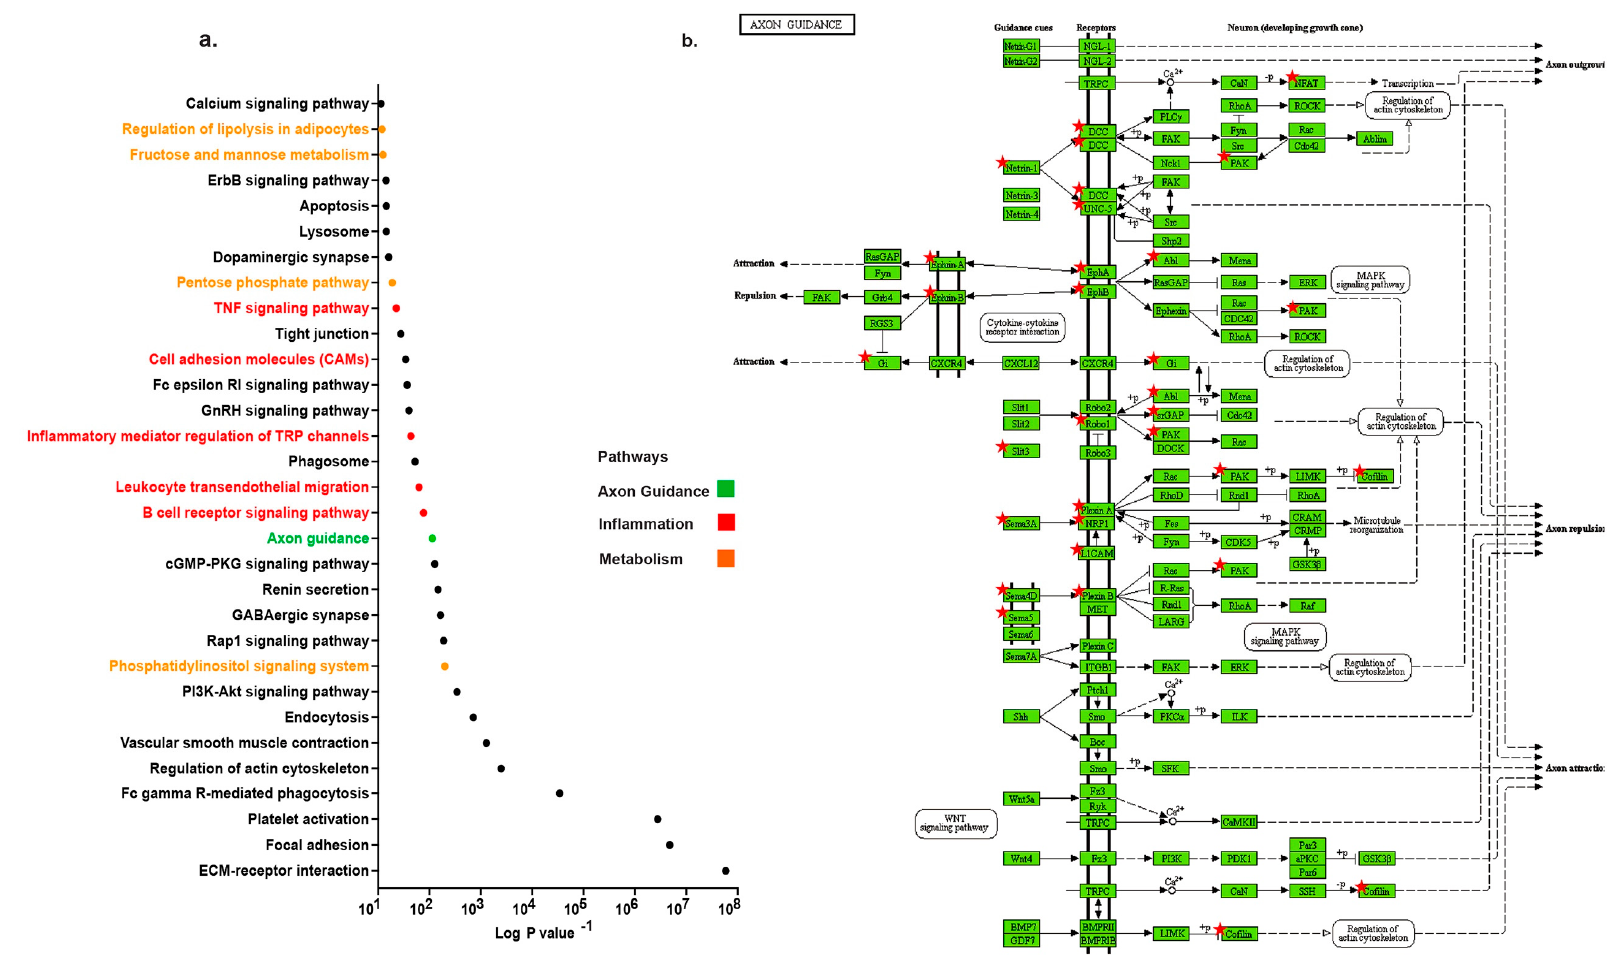
Figure 1. Distinct up-regulation of axonal guidance pathway. ( a ) Graphic representation of selected up-regulated pathways in thoracic aortic aneurysm samples compared to internal thoracic artery for the genes with p < 0.05 and fold change > 2. ( b ) Schematic of KEGG enrichment pathway for the set of genes for axon guidance signaling in thoracic aortic aneurysm (TAA). The genes indicated by a star are predicted as increased in TAA.